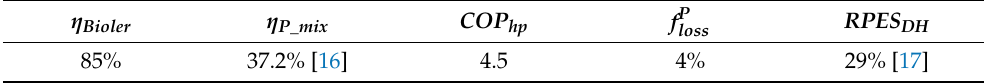
Table 4. Reference values of operating parameters for RPES evaluation.